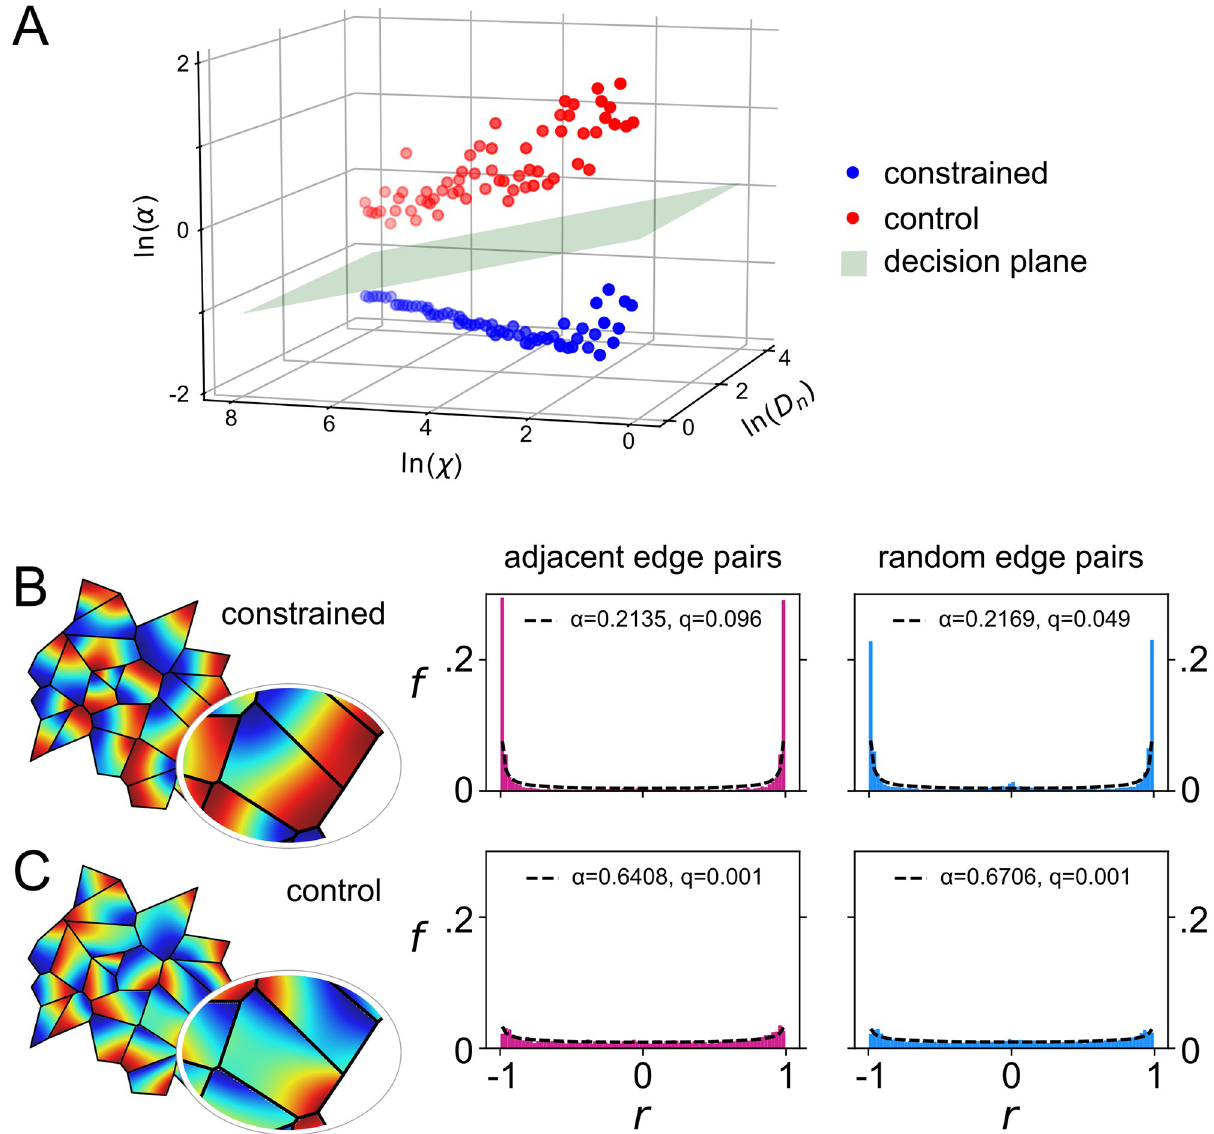
Fig 4. Analysis of control patterns formed without shaped boundary constraints registers only very weak correlations. Combinations of eight values of the diffusion constant D and eight values of the constant χ that weights the non-linear coupling term were evaluated on domains of a Voronoi n tessellation generated from random seed points. The remaining free parameter, D c was set to 0.3 D n , and increments in χ were expressed as proportions of D to cover a large parameter space. In the ‘constrained’ condition, the shapes of the domain boundaries were a constraint on pattern formation. In n the ‘control’ condition, solutions were obtained in circular domains, and the tessellation boundaries were imposed only after pattern formation, to allow a corresponding set of correlations to be measured for comparison. A Values of α were obtained in each condition and for each parameter combination by fitting the resulting distribution of adjacent-edge correlations. Only weak bimodality (high α ) was observed in the control condition. Following a log transformation to each axis, α values were clearly linearly separable, as confirmed by the success of a perceptron in discriminating the two conditions (perceptron decision boundary shown in green). Example solutions in the constrained and control conditions are shown in B and C , respectively, for the combination of parameters ( D n = χ = 36) that yielded the lowest α values in the control condition ( α =